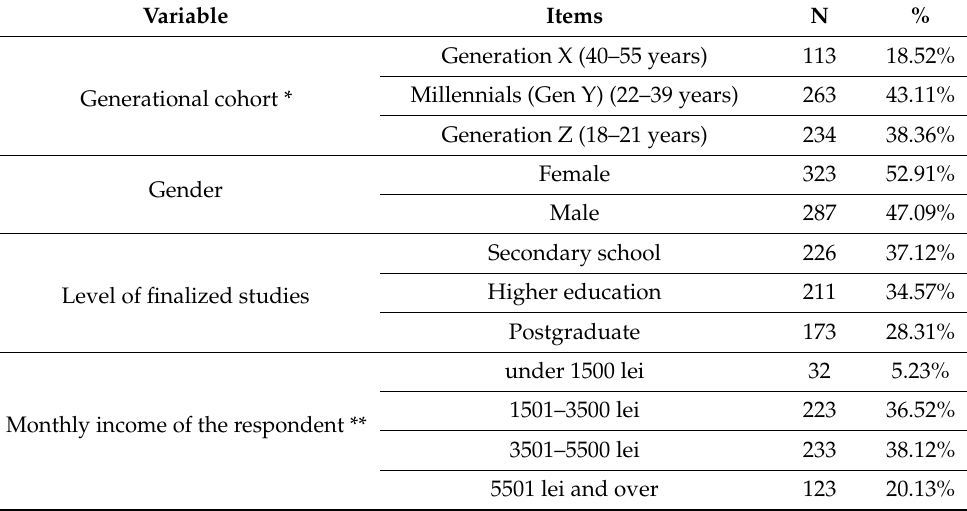
Table 1. Sample structure.